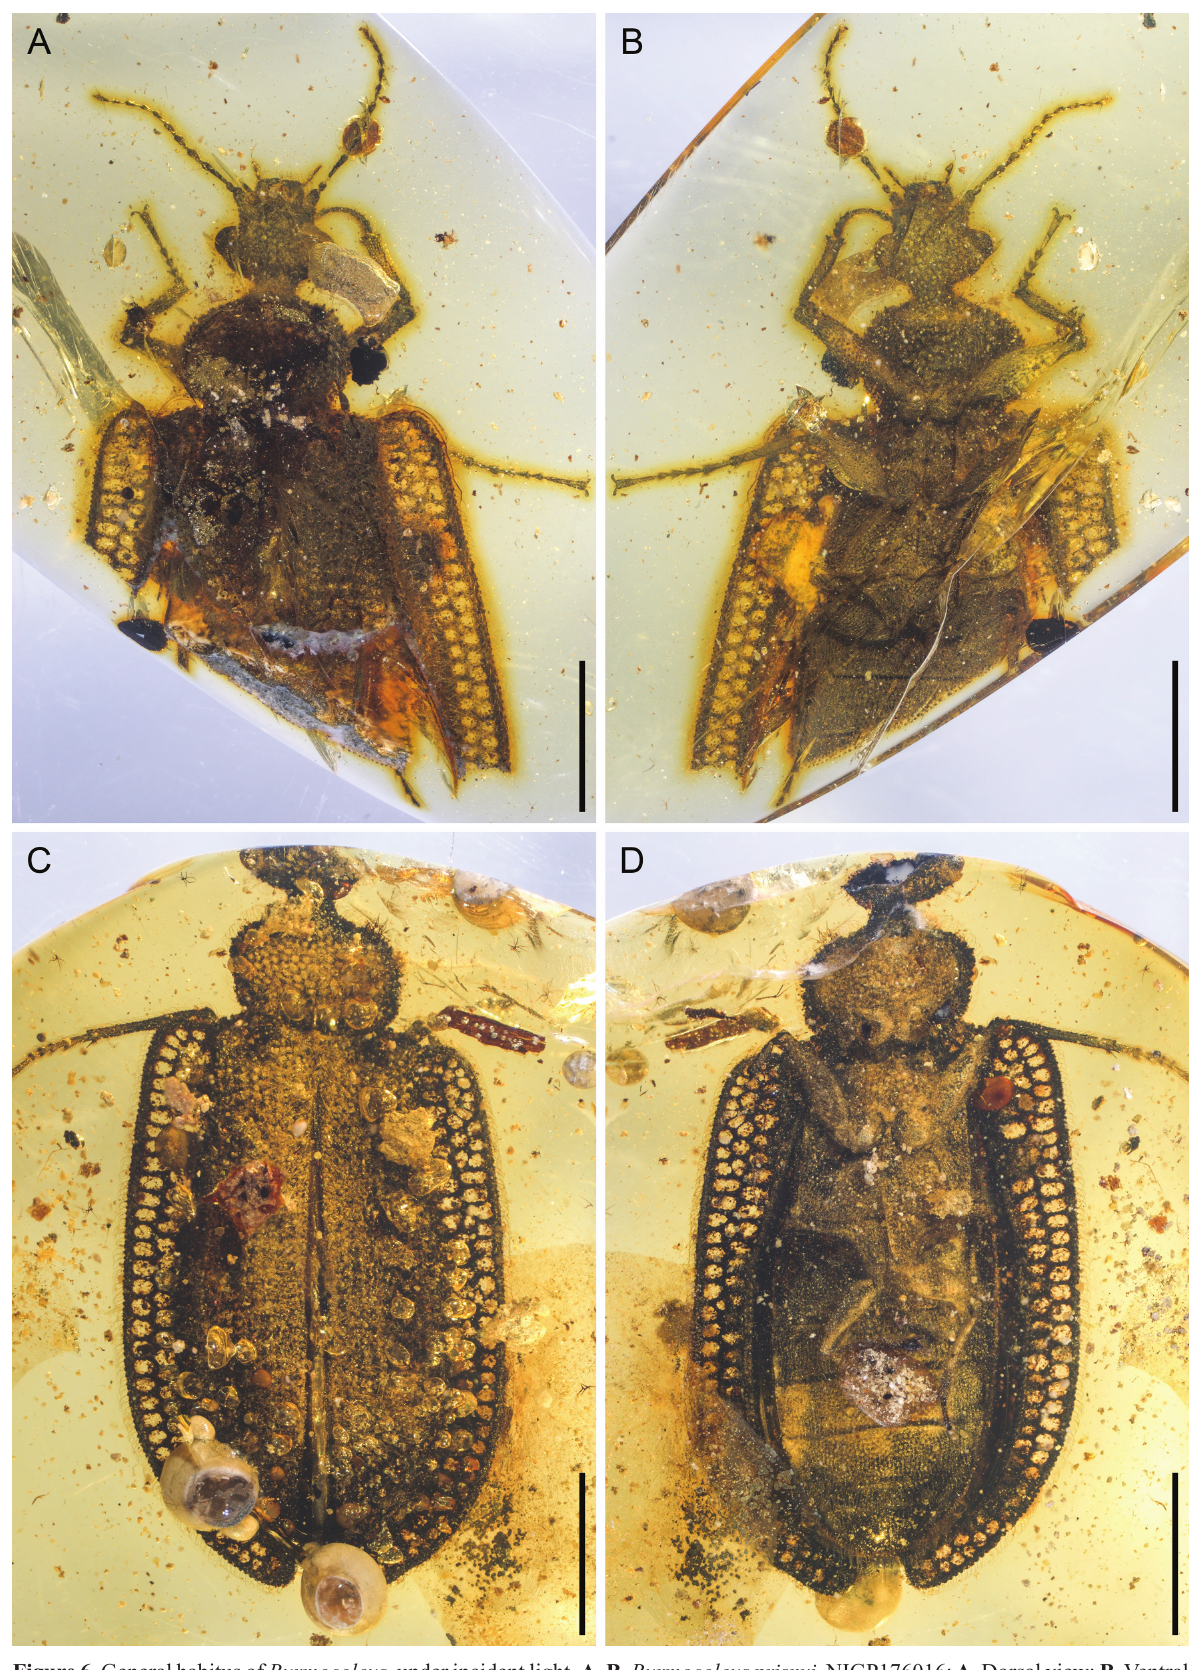
Figure 6. General habitus of Burmocoleus , under incident light. A, B. Burmocoleus prisnyi , NIGP176016; A. Dorsal view; B. Ventral view; C, D. Burmocoleus sp., NIGP176017; C. Dorsal view; D. Ventral view. Scale bars: 3